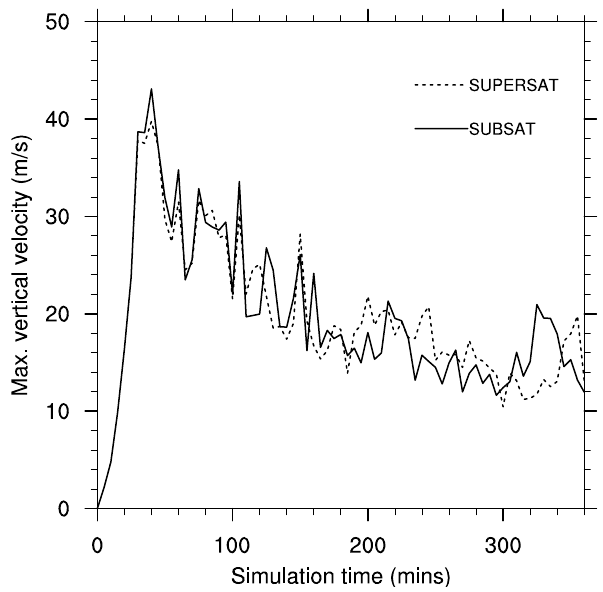
Fig. 3. Time series of maximum vertical velocity throughout the